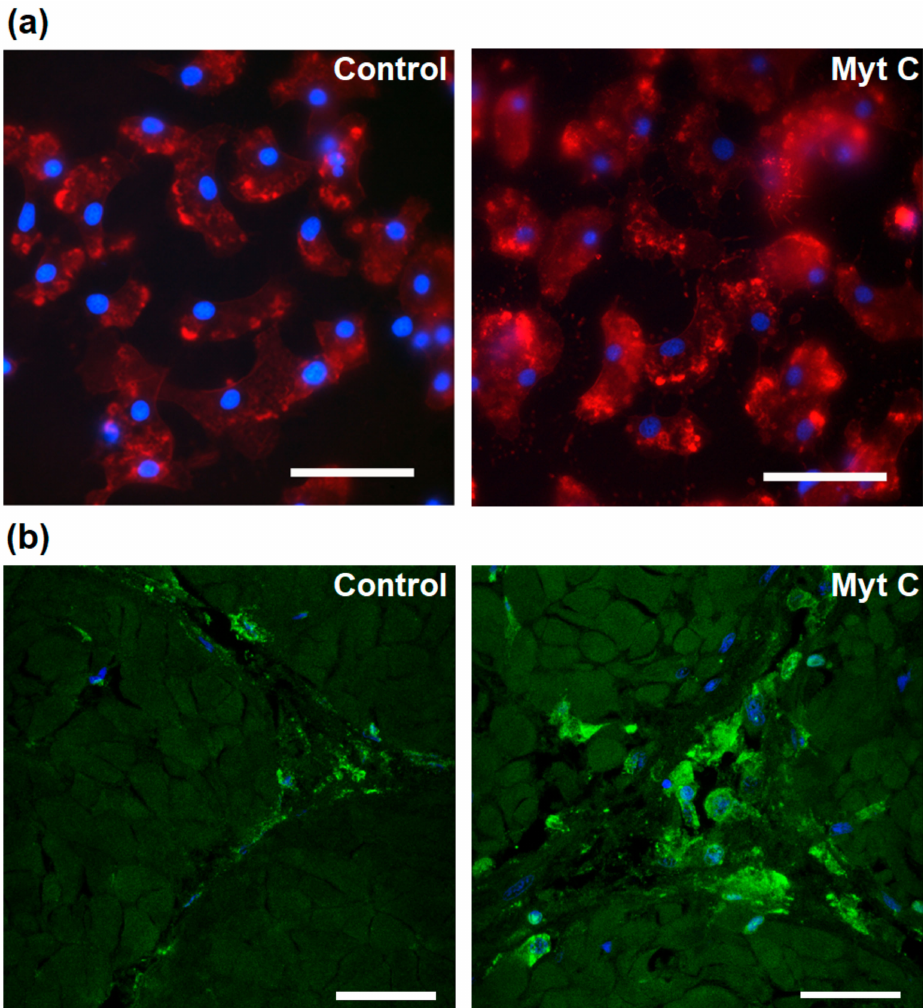
Figure 2. ( a ) Di ff erential interference contrast (DIC) images of live hemocytes 3 h after stimulation with myticin C. Actin is stained in red and nuclei in blue. Scale bar = 25 µ m. ( b ) Immunofluorescence of mussel adductor muscle. Actin is stained in green and nuclei in blue. Scale bar = 25 µ